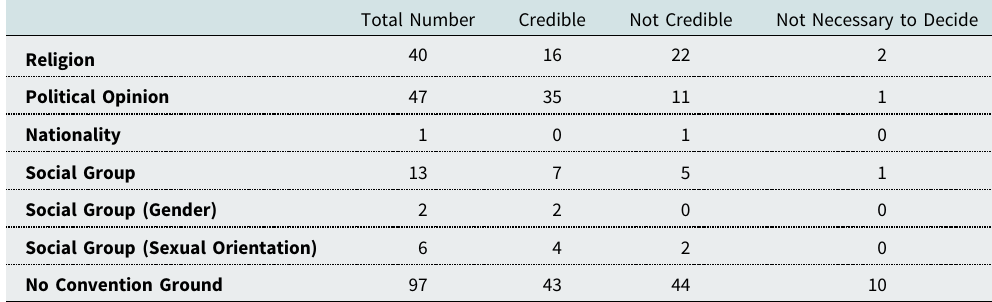
Table 1. Persecution Grounds